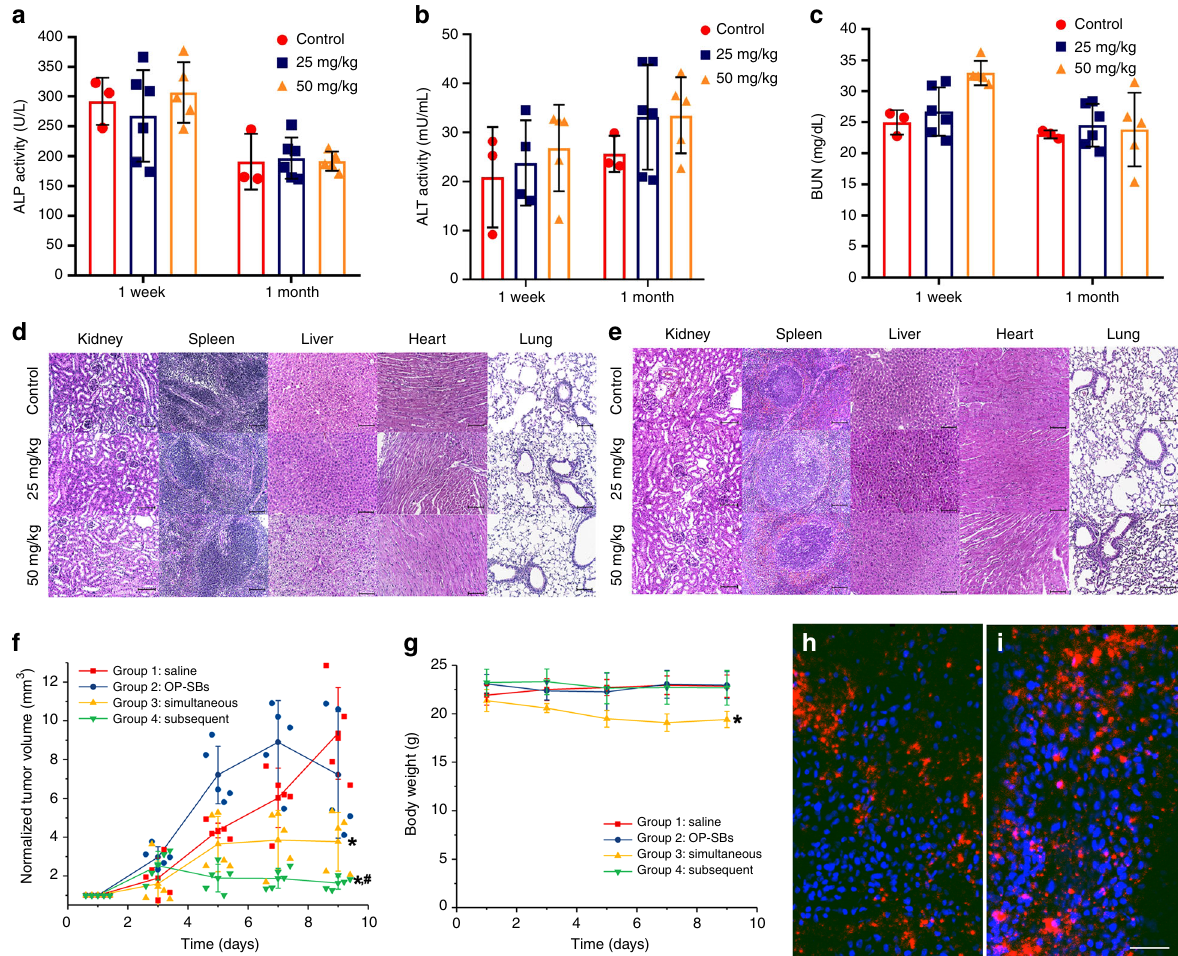
Fig. 4 Photoactivation of therapeutic processes using OP-SBs in vivo. Serum levels of alkaline phosphatase (ALP) activity ( a ), alanine aminotransferase (ALT) activity ( b ) and blood urea nitrogen (BUN) ( c ), in mice injected intravenously with OP-SBs at doses of 0 (untreated controls), 25 and 50 mg/kg and sacri fi ced at 1 week and 1 month post injection. Error bars represent the standard deviation of measurements from three ( n = 3) distinct samples. d , e Hematoxylin and eosin staining of tissue sections obtained from the mice major organs at 1 week and 1 month post injection of the OP-SBs, showing that the histological features between mice intravenously injected with OP-SBs of dose 0 (control), 25 and 50 mg/kg, scale bar is 100 μ m. f Tumor regression studies of Cal27 tumors on Balb/c nude mice injected with different nanoformulations and irradiated with a 980 and/or 808 nm NIR laser. g Body weight of treated mice over the treatment period. h , i Distribution of OP-SBs@azo-Psi in tumor at 8 and 24 h after intratumoral injection, scale bar is 100 μ m. Error bars represent the standard deviation of measurements from fi ve ( n = 5) distinct samples. * p < 0.05 in comparison to Group 1 (ANOVA), * # p < 0.05